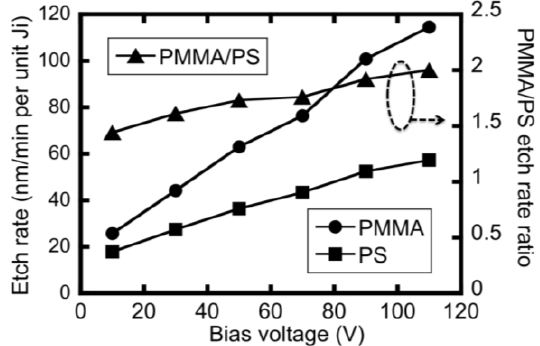
Figure 6. PMMA etch rates in Ar/O PS (221%), for bias voltage magnitudes of 10 V to 110 V.